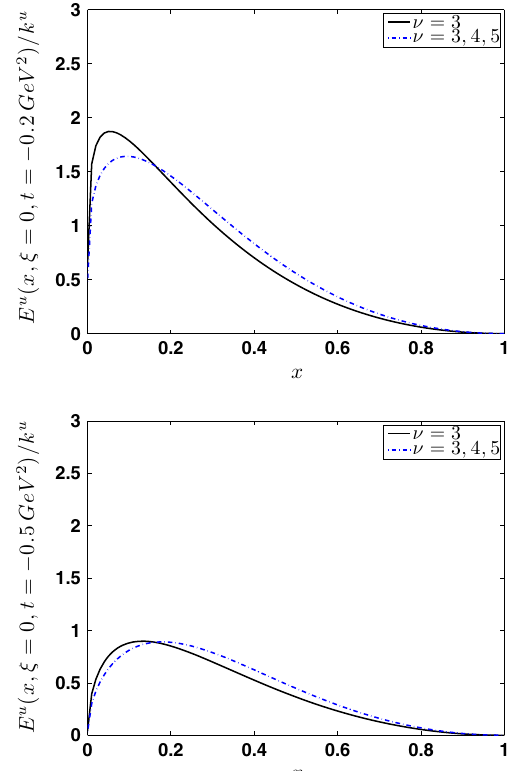
trum (cf. Sect. 2.1). In the literature the values α = 0 .